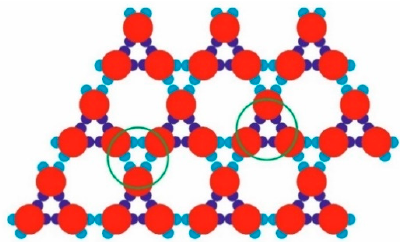
Figure 6. Two types of alternating trimers bonded by three SN or three WW bonds (marked with green circles), observed in the already formed TriHex periodic structure.